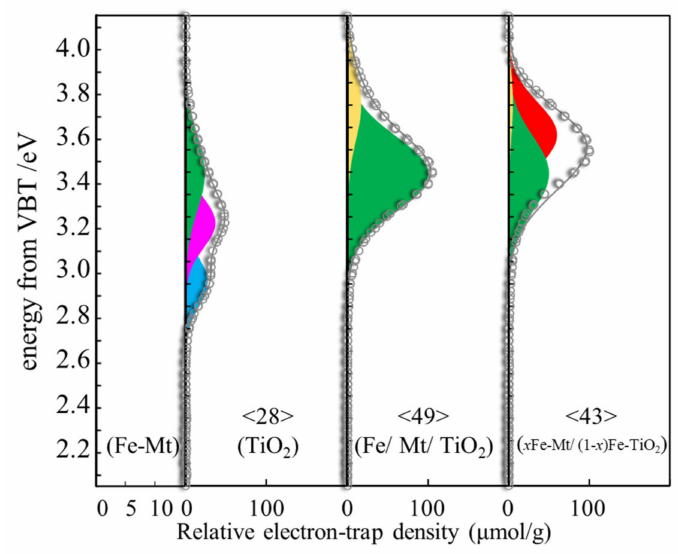
Figure 11. Peak separation of the representative energy-resolved distribution of electron traps (ERDTs) patterns of Fe-Mt synthesized at RT, and TiO 2 , Fe/Mt/TiO 2 , and x Fe-Mt/(1 − x )Fe-TiO 2 synthesized at 70 ◦ C plotted as a function of energy (eV) from the valence band top (VBT) combined with CBB. The numbers in brackets denote the relative total electron trap density. Peaks at 2.96, 3.22, 3.44, and 3.62–3.76 eV were assigned as crystal rutile, amorphous rutile, amorphous rutile covered on crystal anatase, and isolated amorphous TiO 2